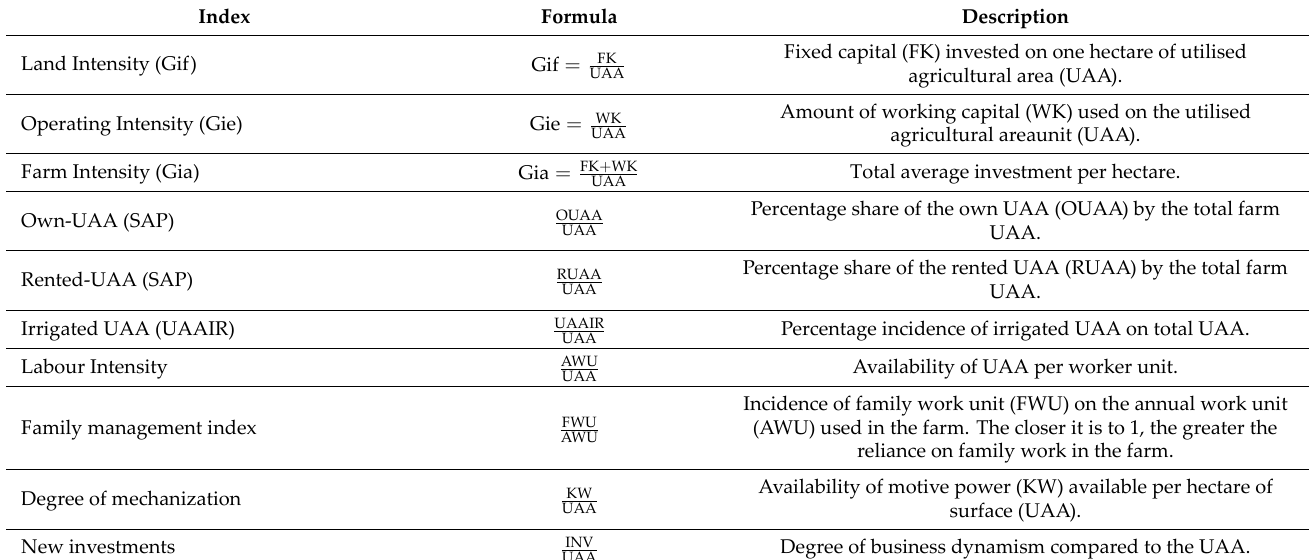
Table A1. Structural indexes used and their brief description.